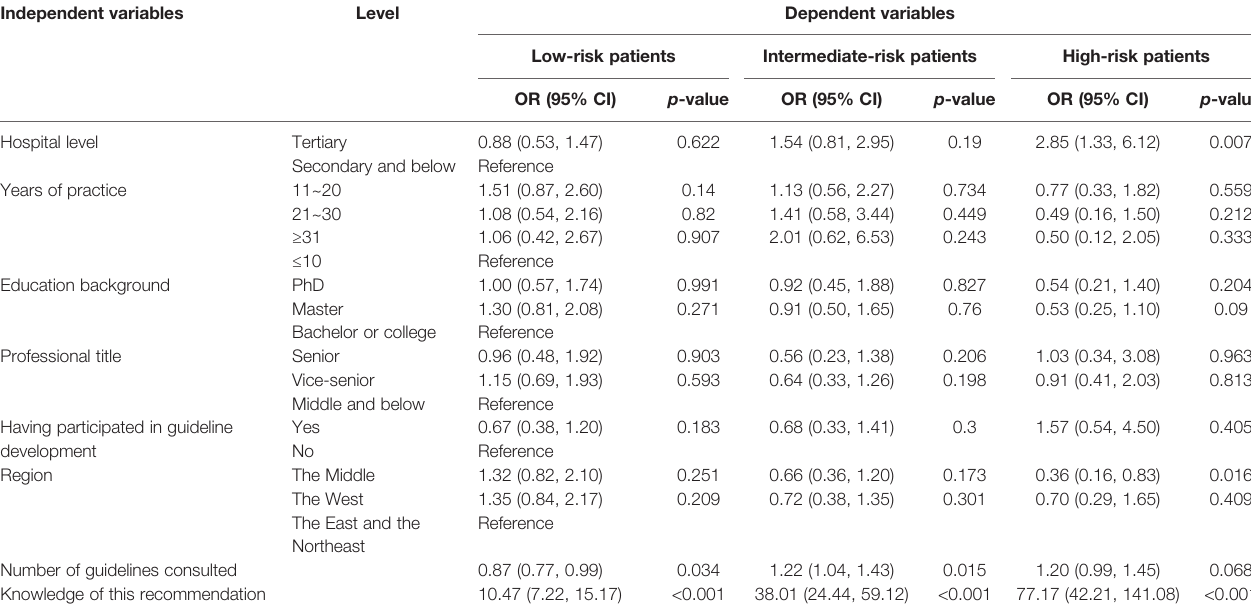
TABLE 5 | Multivariable logistic regression of compliance with recommendation about BCG immunotherapy. Independent variables